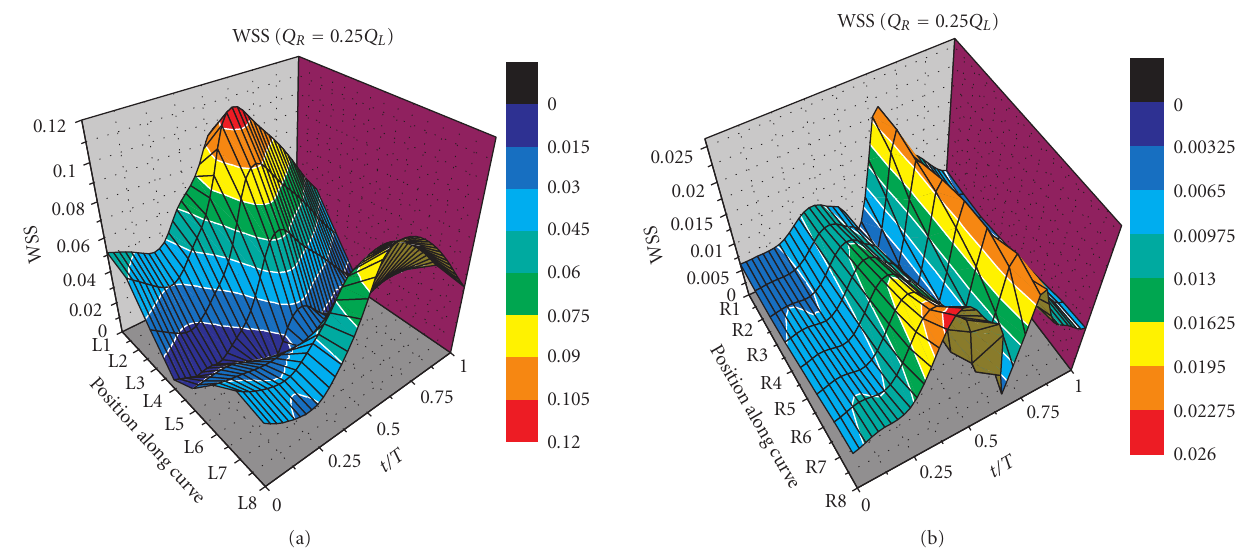
Figure 11: WSS versus position and time for Q R = 0 . 25 Q L on (a) the left and (b) the right bifurcation